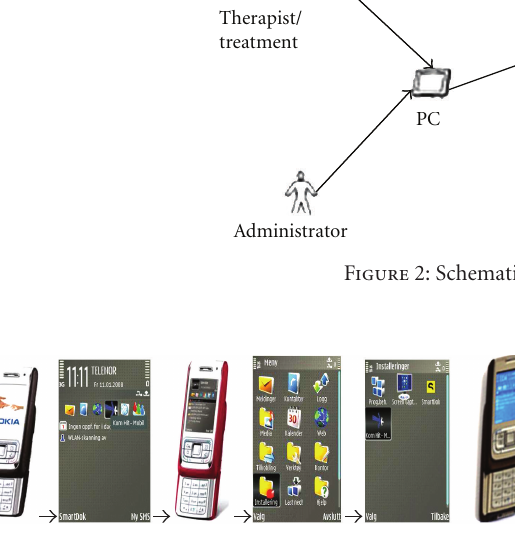
Health Network is not included in this new solution.